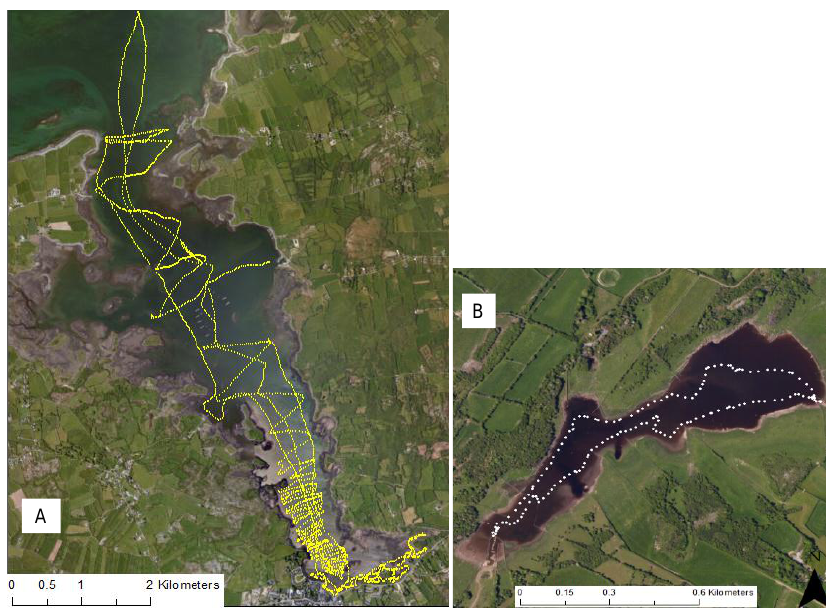
Figure 5. Location of in-situ data points collected over a four-day sampling campaign in ( A ) Kinvara Bay and ( B ) Cahergluassuan Turlough (25–28 August 2015).